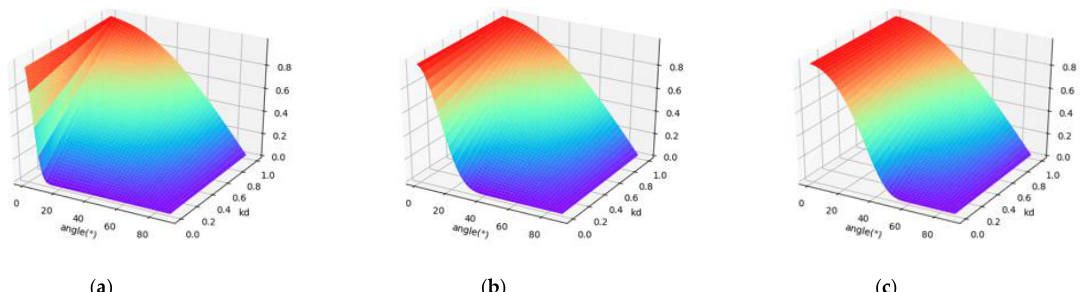
Figure 3. The variation of the backscatter intensity, I ( θ , λ ) , with the incident angle, θ , and k d ( λ ) . Parameter m is fixed at 0.1, 0.3, and 0.5, respectively. ( a ) m = 0.1; ( b ) m = 0.3; (c) m = 0.5.